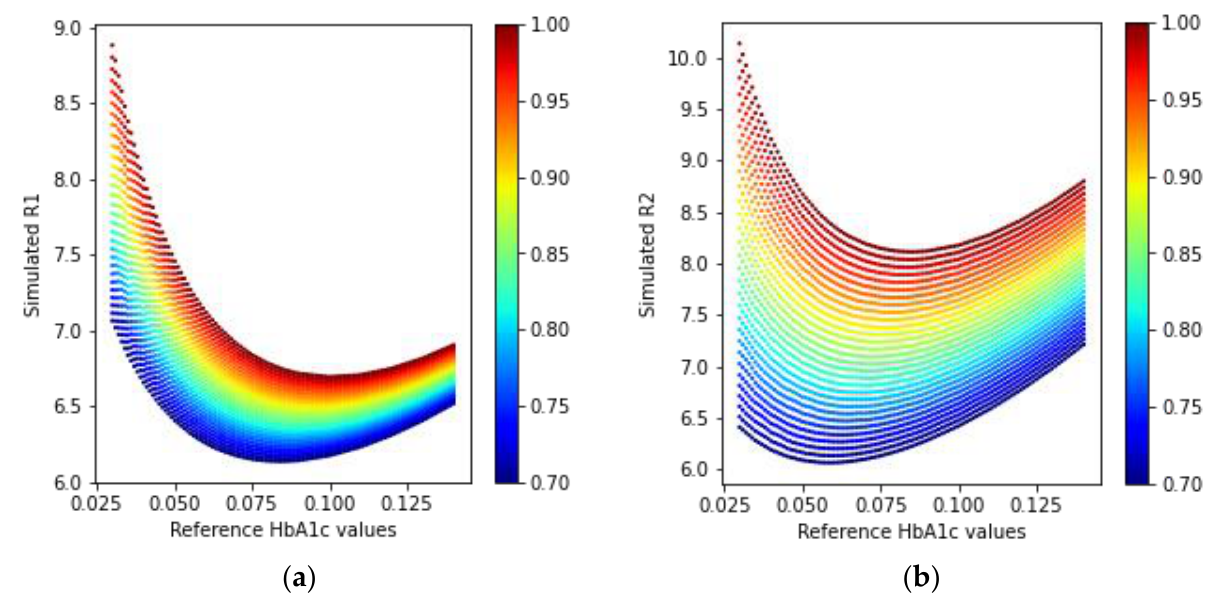
Figure 15. Simulated ratio values ( a ) R1 and ( b ) R2 from the received intensities in the one PD and multiple wavelength LEDs arrangement of the wrist model. The color bars at the side of the plots indicate the different SpO 2 values ranging from 70% to 100%.